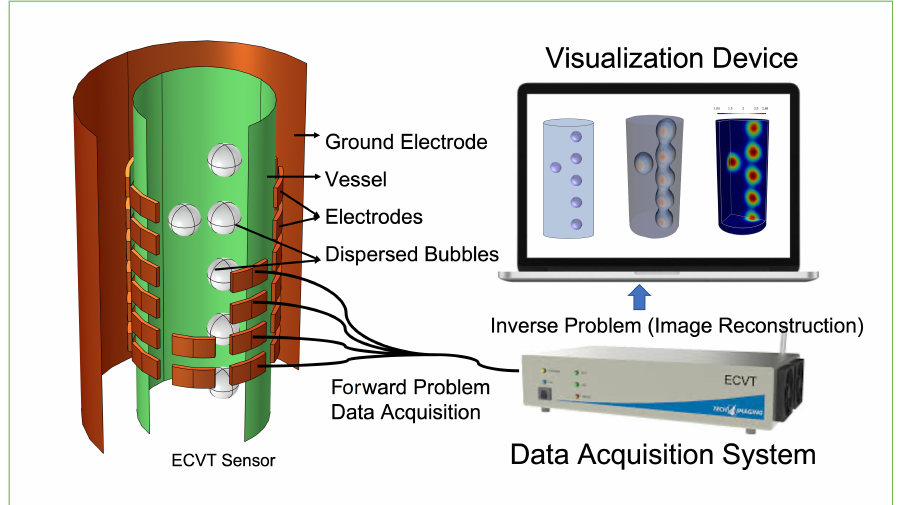
Figure 1. Schematic representation of an ECVT setup used in multiphase flow